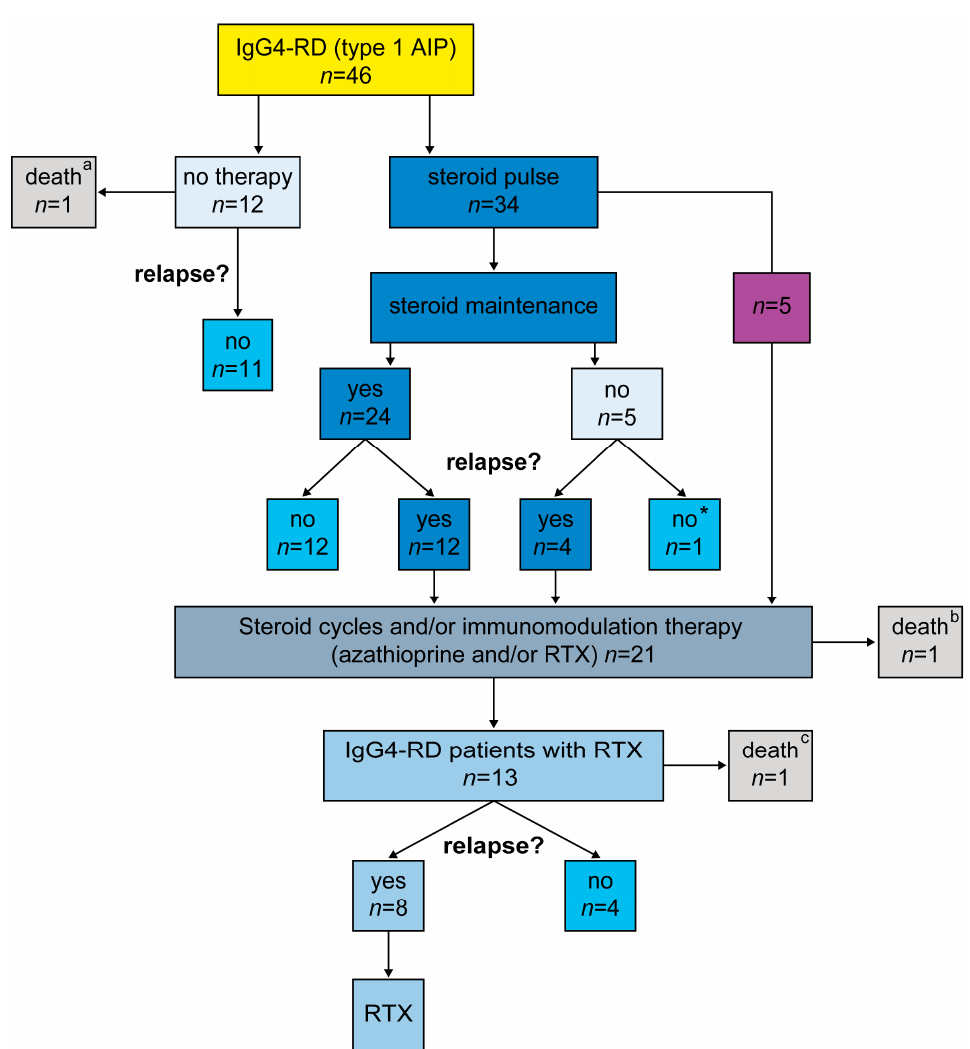
Figure 1. Diagram showing different treatment regimens in patients with IgG4-RD. IgG4-RD: IgG4-related disease; RTX: rituximab; * a patient lost to follow-up after steroid pulse therapy; a a patient with histologically confirmed IgG4-RD not on medication, who died from complications after surgery for suspected cancer; b a patient treated after relapse with steroids, who died from intraductal papillary mucinous neoplasm that progressed to pancreatic cancer; c a patient who had been treated with steroid pulse therapy and RTX (as a last resort) but died from sepsis.